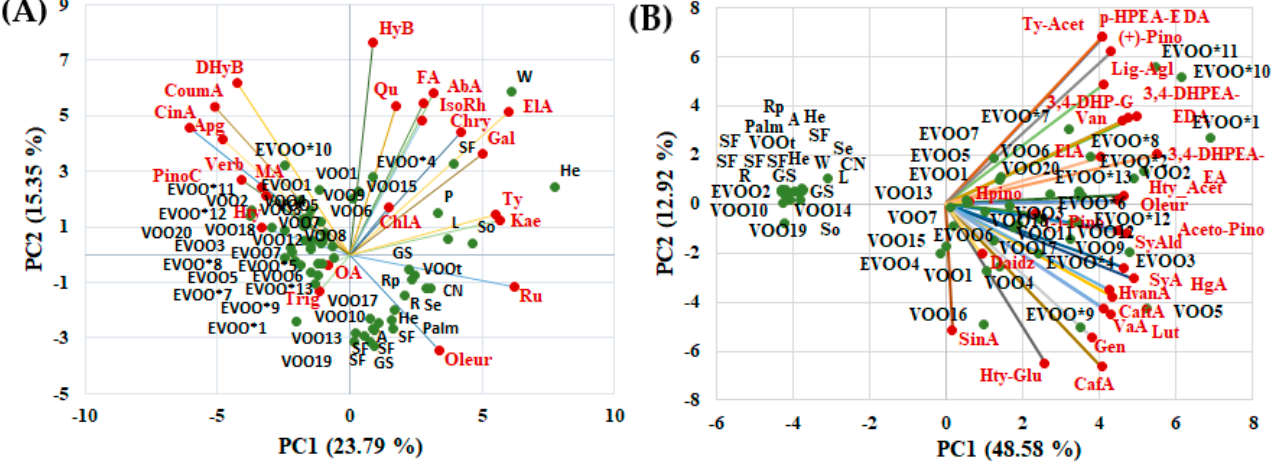
Figure 3. PCA results (scores and loading biplots) of different vegetable oils based on: ( A ) targeted HRMS analysis of phenolic compounds and triterpenic acids biomarkers and ( B ) untargeted HRMS screening analysis. (EVOO*—authentic extra-virgin olive oils; EVOO—commercial extra-virgin ol-